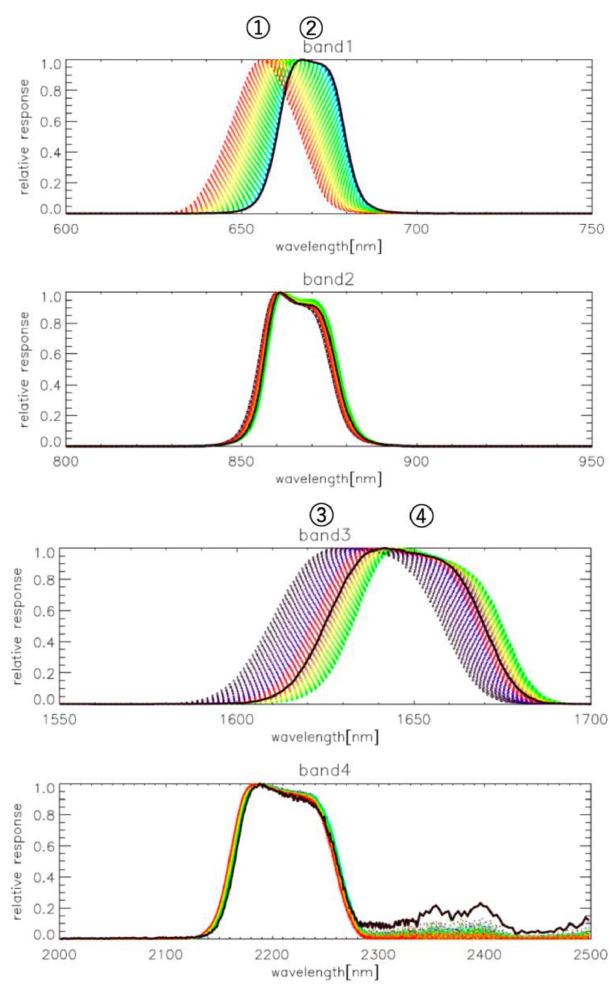
Figure 2. Wavelength distribution of relative response function on MSI bands 1 to 4 (Value from flight model). The bold line shows the nadir value. Points 1 to 4 show the positions of Pix_BND1_min, Pix_BND1_max, Pix_BND3_min, and Pix_BND3_max respec-